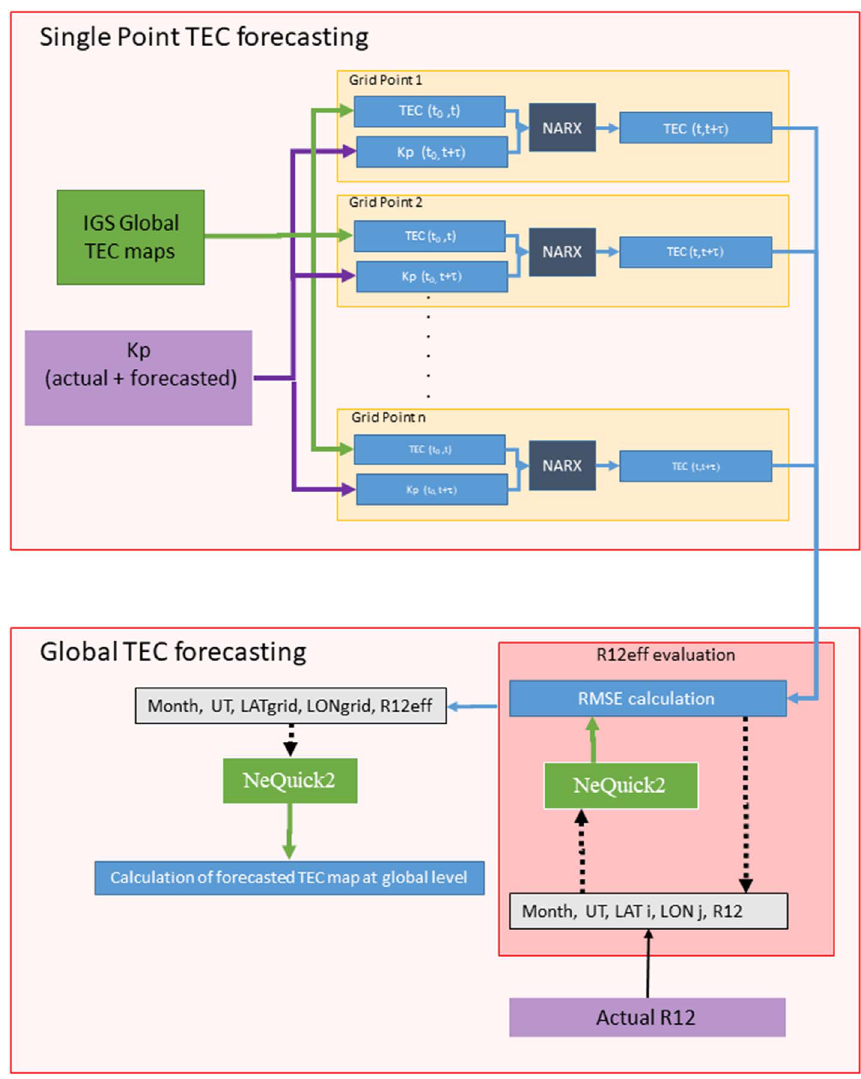
Fig. 1. Flowchart of the